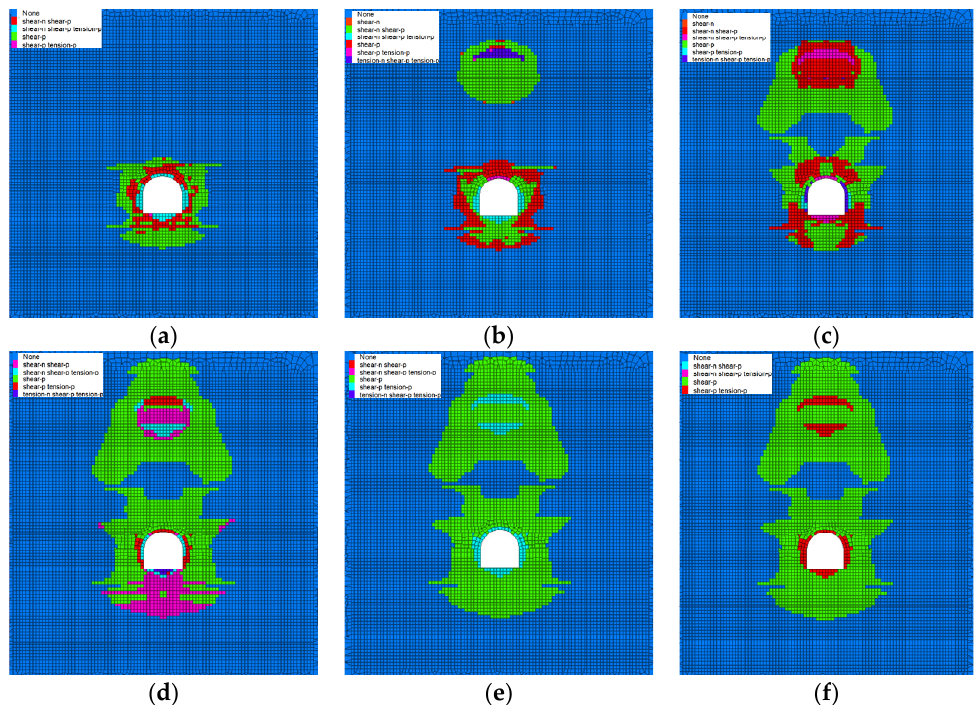
Figure 7. Evolution Nephogram of Plastic Zone under Dynamic Load Disturbance. ( a ) before dynamic load disturbance; ( b ) dynamic load disturbance of 0.01 s; ( c ) dynamic load disturbance of 0.03 s; ( d ) dynamic load disturbance of 0.05 s; ( e ) dynamic load disturbance of 0.07 s; ( f ) dynamic load disturbance of 0.09 s.